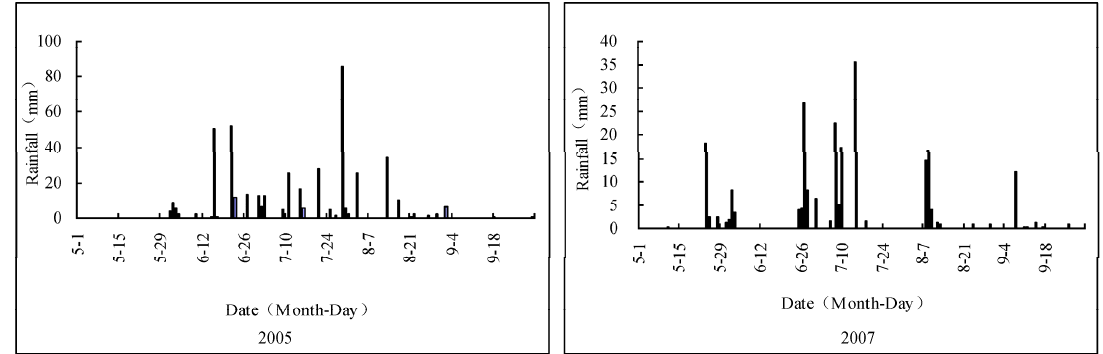
Figure 3. Rainfall Regulations during Different Hydrological Years.